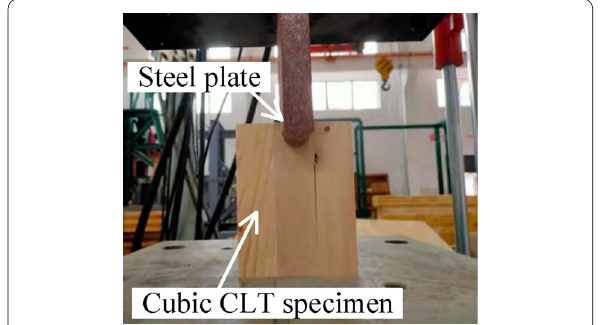
Fig. 5 Half-hole embedment test configuration